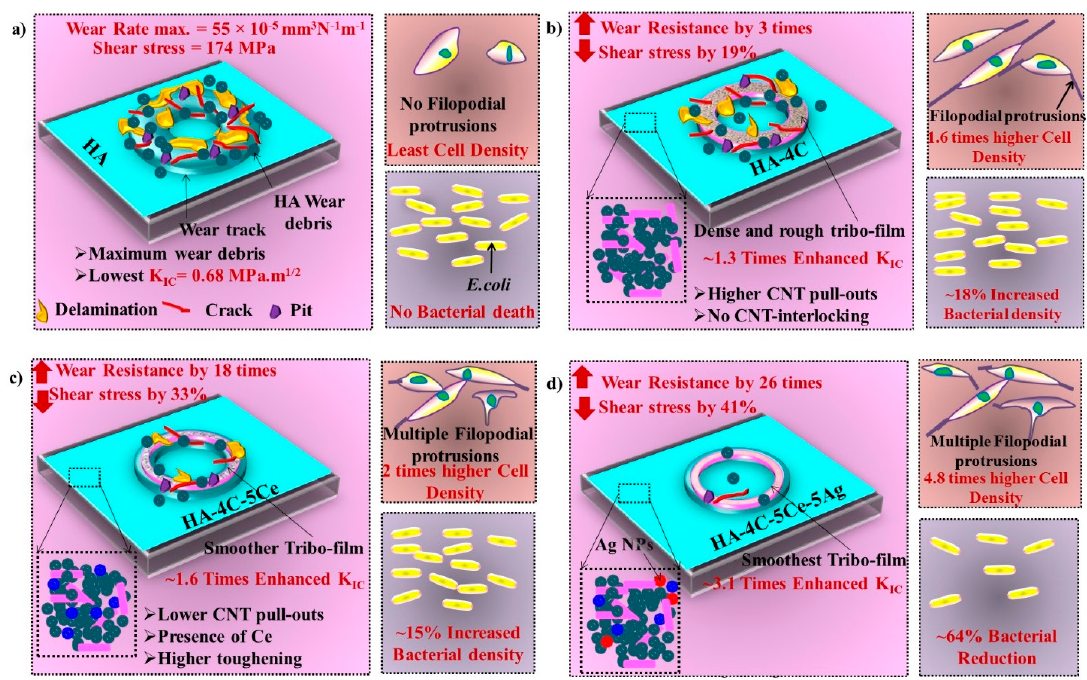
Figure 11. Schematic representing the plausible mechanisms involved for tribological resistance and fracture toughness, cell density, and bacterial adhesion on ( a ) HA-, ( b ) HA-4C-, ( c ) HA-4C-5Ce-, and ( d ) HA-4C-5Ce-5Ag-coated TiAl6V4 substrate.